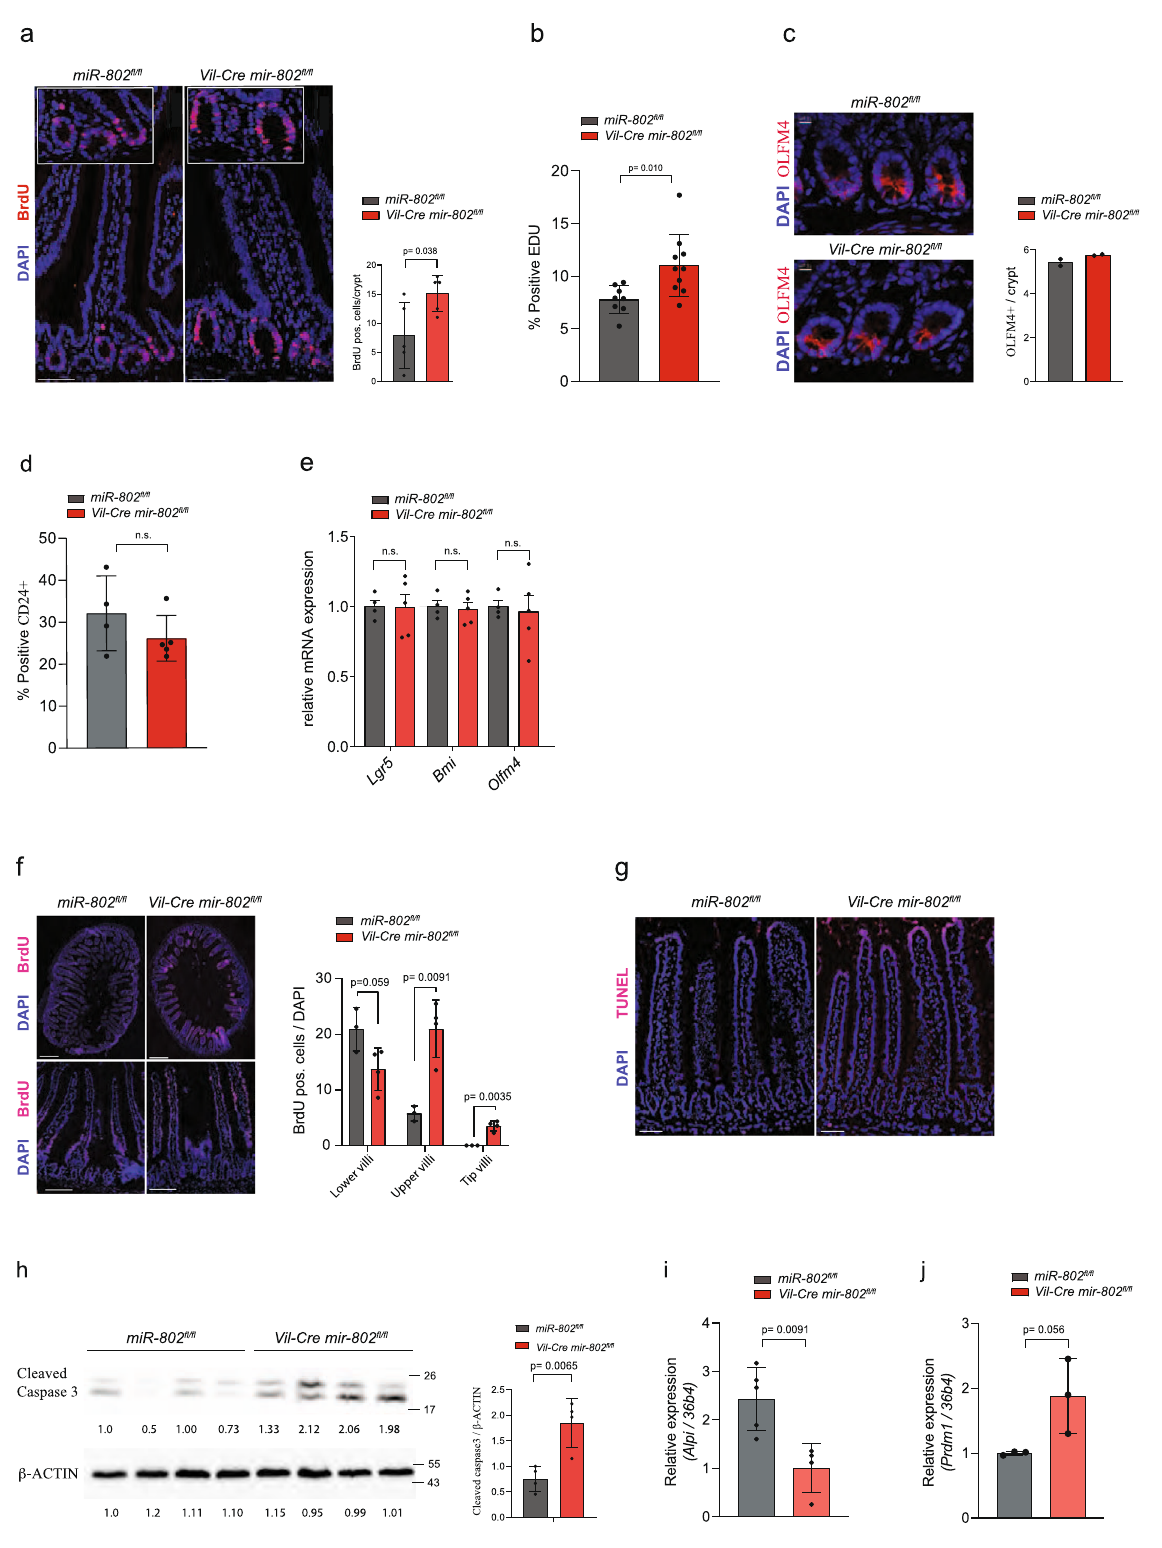
repressor that delays postnatal epithelial maturation 30,31 (Fig. 3j). These data imply that miR-802 in the intestinal epithelium increases proliferation, accelerates epithelial cell turnover, perturbs absorptive enterocyte differentiation, and increases